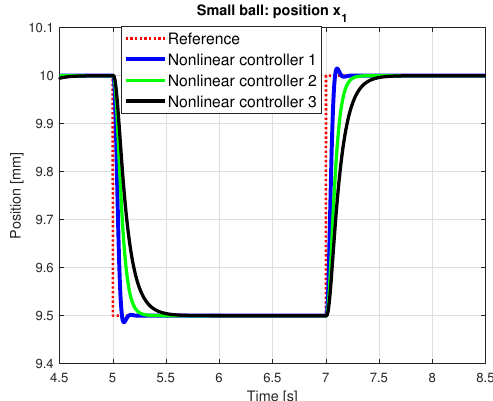
Figure 11. Small ball - output position y = x 1 : Simulation results for nonlinear control law, compari- son of three variants of control parameters corresponding to the defined closed-loop poles.